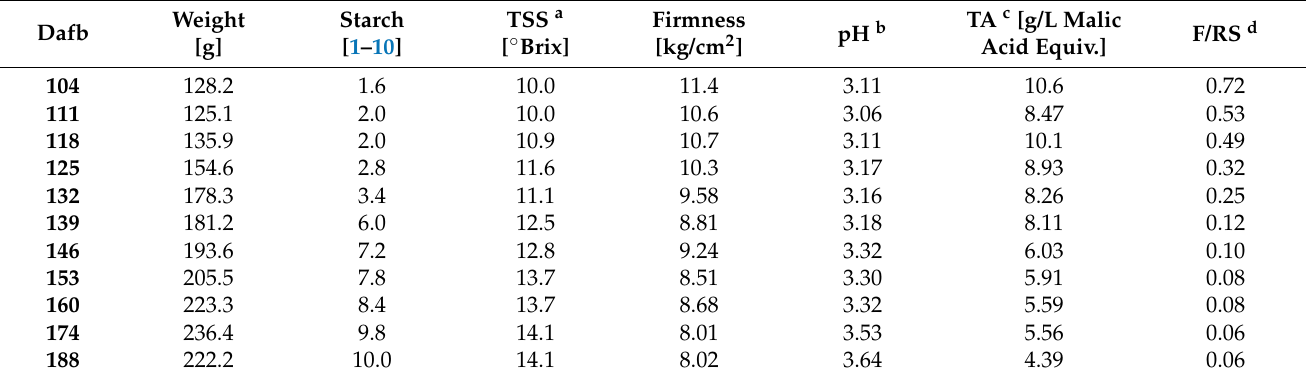
Table 1. Quality attributes of Crimson Crisp apples harvested between 104 to 188